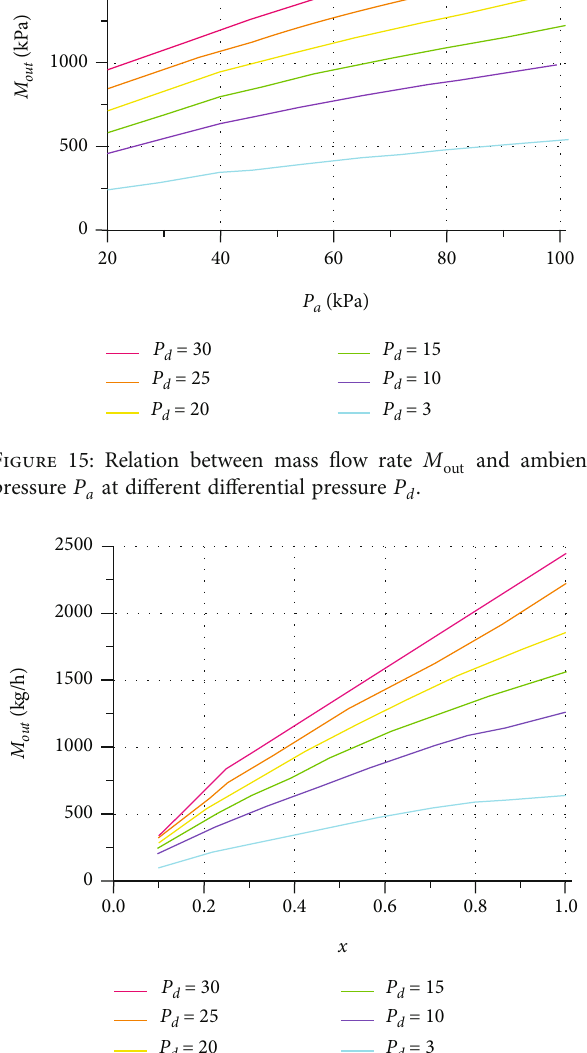
with relative valve out Figure 16: Relation between mass fl ow rate M opening x at di ff erent di ff erential pressure P d